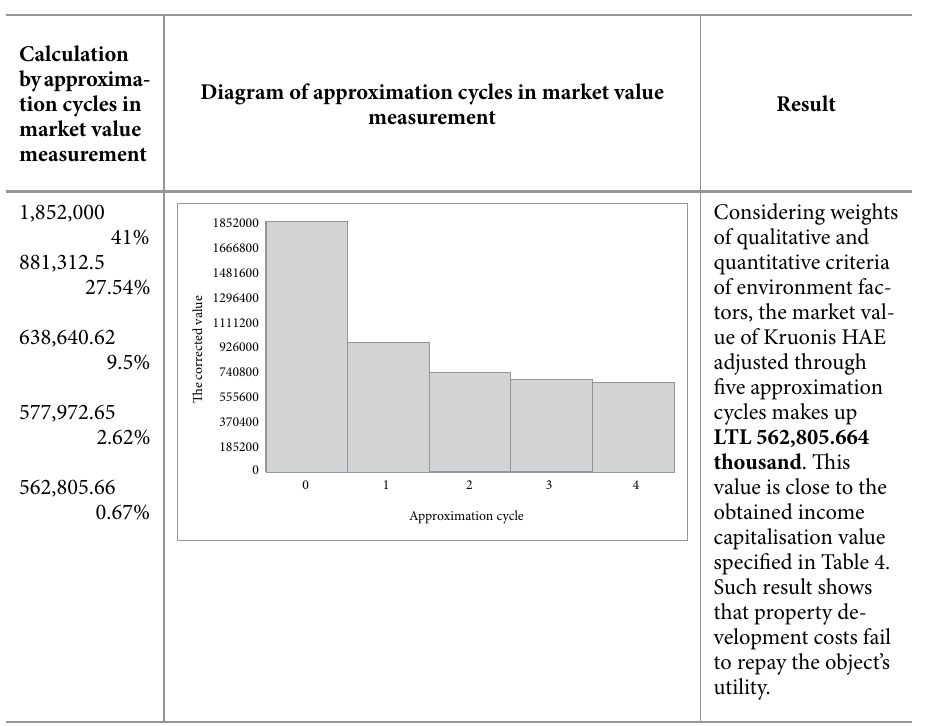
table 8. The result of market value measurement for Kaunas Hydroelectric Power Plant calculation by approxima­ diagram of approximation cycles in market tion cycles in market value measurement